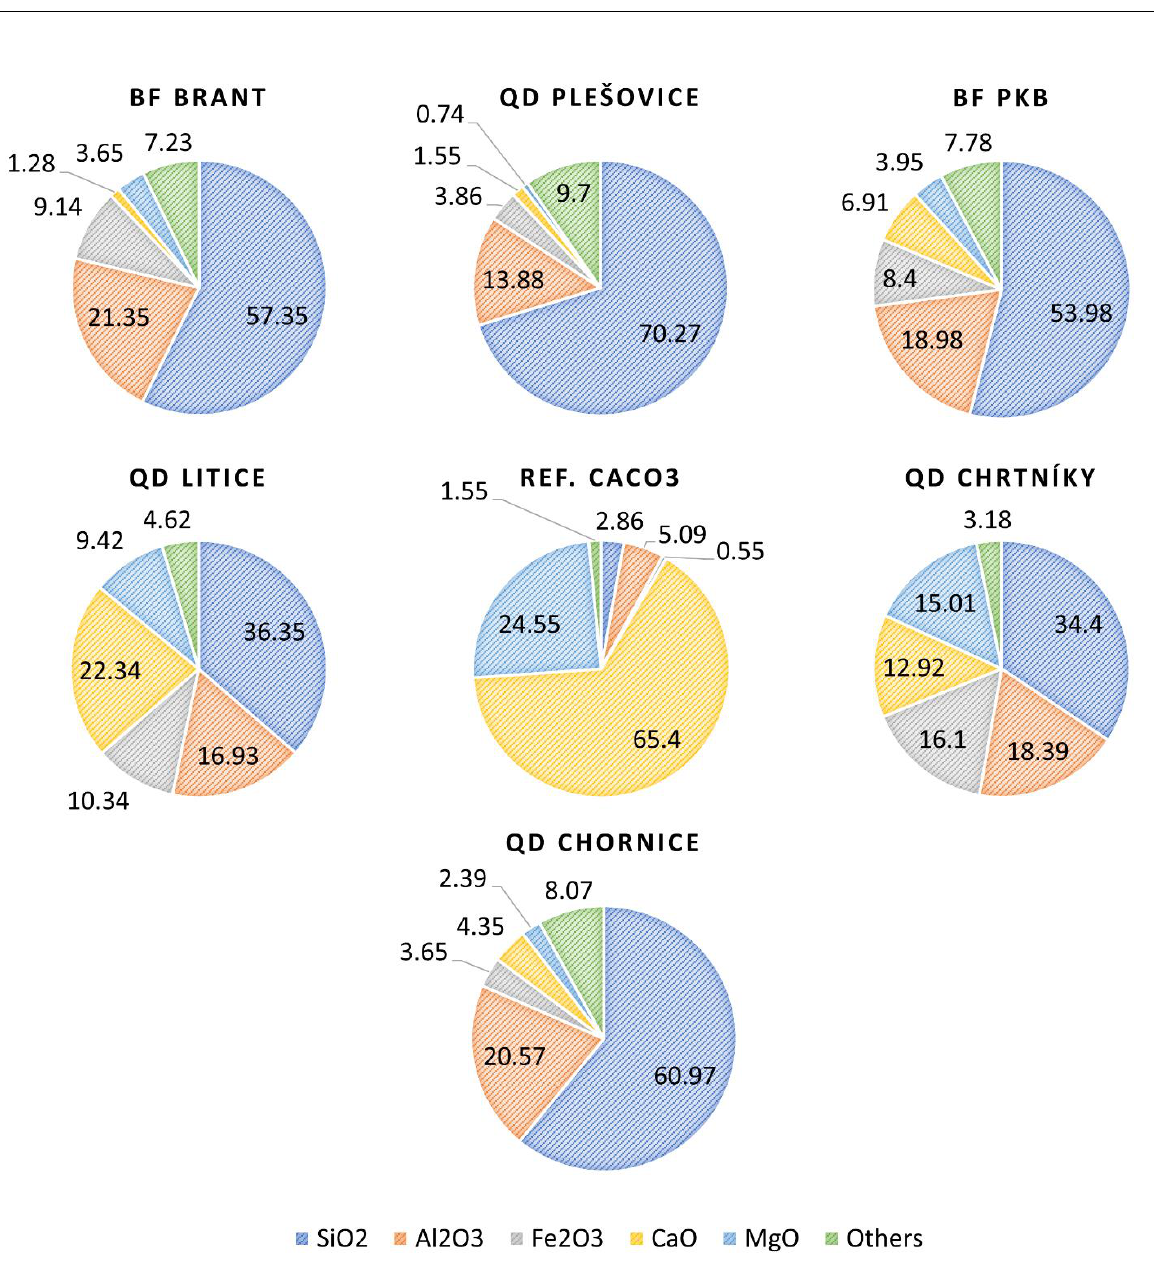
Figure 1. Quarry fillers’ oxide contents determined by means of XRF spectrometry (m/m%).